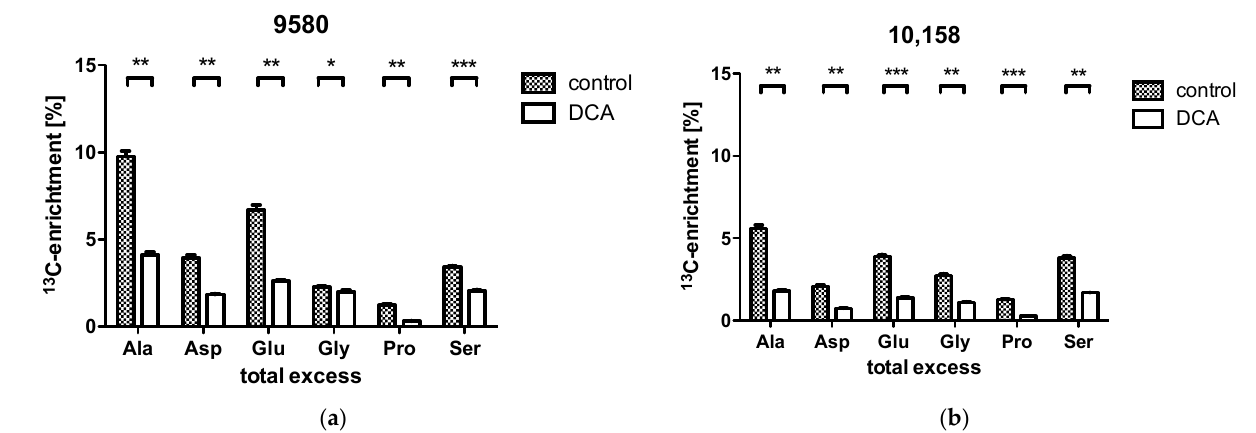
Figure 3. Overall 13 C enrichment in analyzed amino acids of untreated control cells and DCA treated cells. Results are shown for 9580 ( a ) and 10,158 cells ( b ). DCA treatment of 9580 and 10,158 cancer cell lines led to a significant decrease in 13 C-enrichment in alanine (Ala), aspartate (Asp), glutamate (Glu), glycine (Gly), proline (Pro) and serine (ser). * p < 0.05, ** p < 0.01 *** p < 0.0001 compared to controls. Mass fragments of silylated amino acids used for 13 C-determination are indicated. Table 1. Enrichment profiles and percentage of 13 C-enrichment in six selected amino acids in controls and after treatment with DCA in 9580 and 10,158 cancer cell lines. * p < 0.05, ** p < 0.01 *** p < 0.0001 compared to controls. Experiments were carried out as